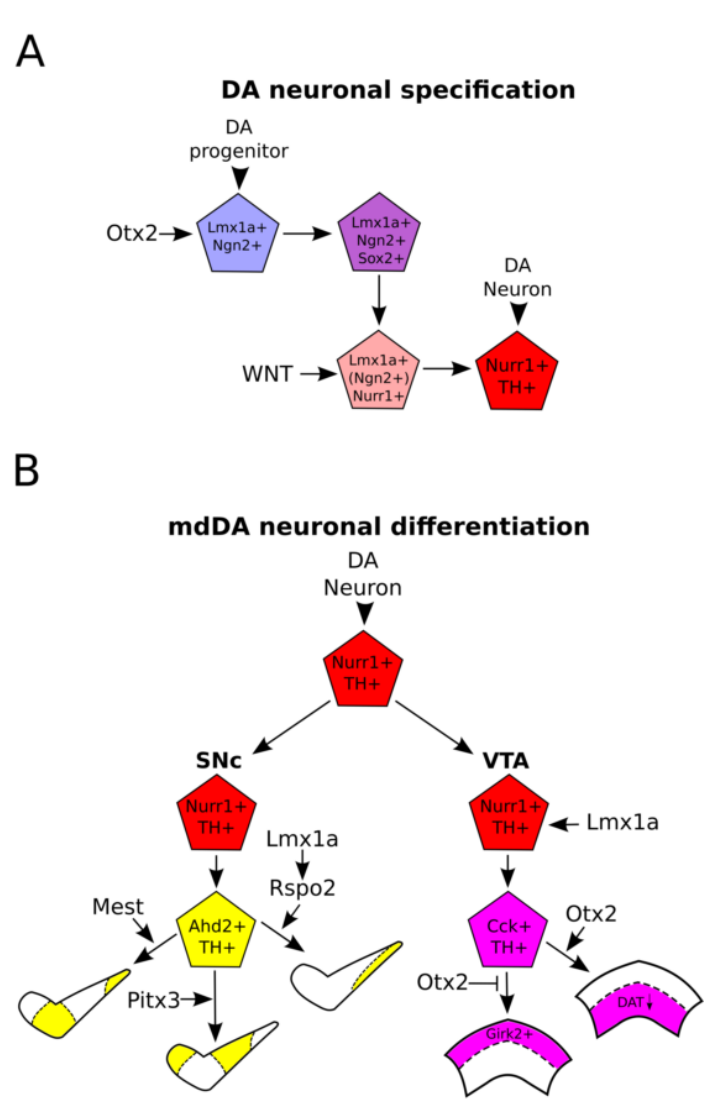
Figure 2. Specification of DA progenitors to a subset-specific mesodiencephalic dopaminergic (mdDA) neuron. ( A ): Schematic representation of the specification of a DA progenitor to an mdDA neuron. DA progenitors expressing Lmx1a and Ngn2 (under control of Otx2 ) further progress in maturation after expression of Sox2 in the VZ of the mesodiencephalic FP. Lmx1a + / Ngn2 + / Sox2 + DA progenitors leave the VZ and become Lmx1a + / Nurr1 + , of which a small subset of intermediate precursors still express Ngn2 . Lmx1a + / Nurr1 + DA precursors become Nurr1 + / TH + mdDA neurons under the influence of WNT signaling. ( B ): Schematic representation of subset di ff erentiation of mdDA neurons. mdDA neurons